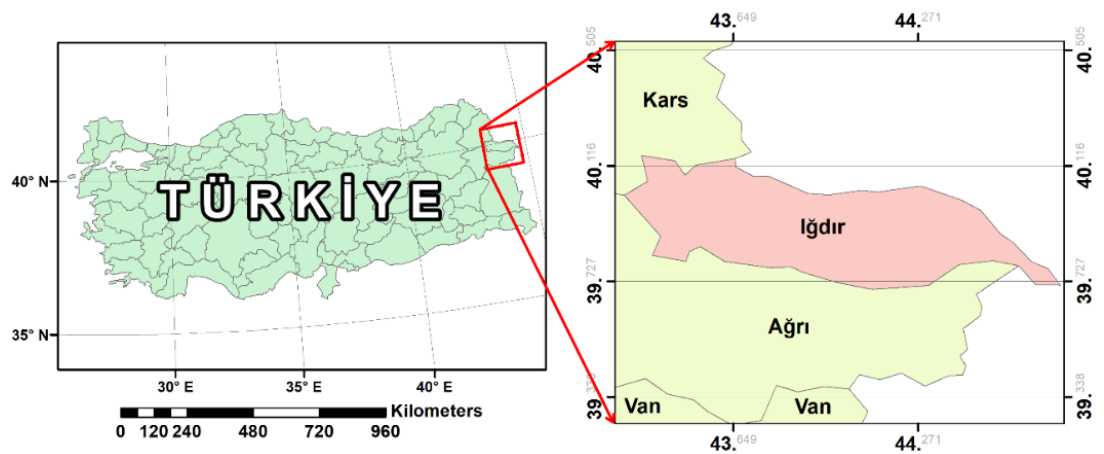
Figure 1. Illustration of the study area map for LULC classification.